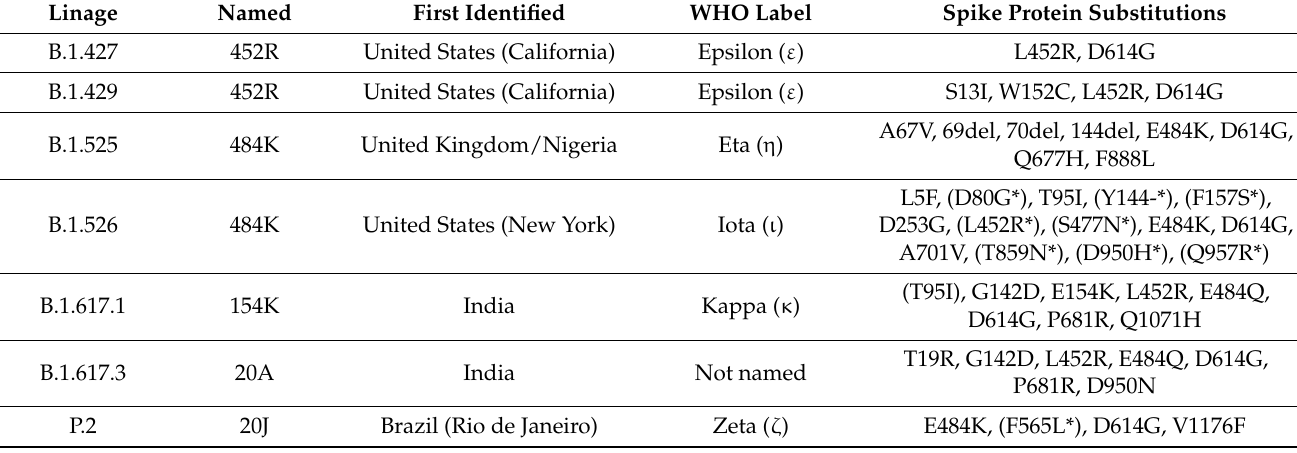
Table 1. Characteristics of SARS-CoV-2 Variants of Interest